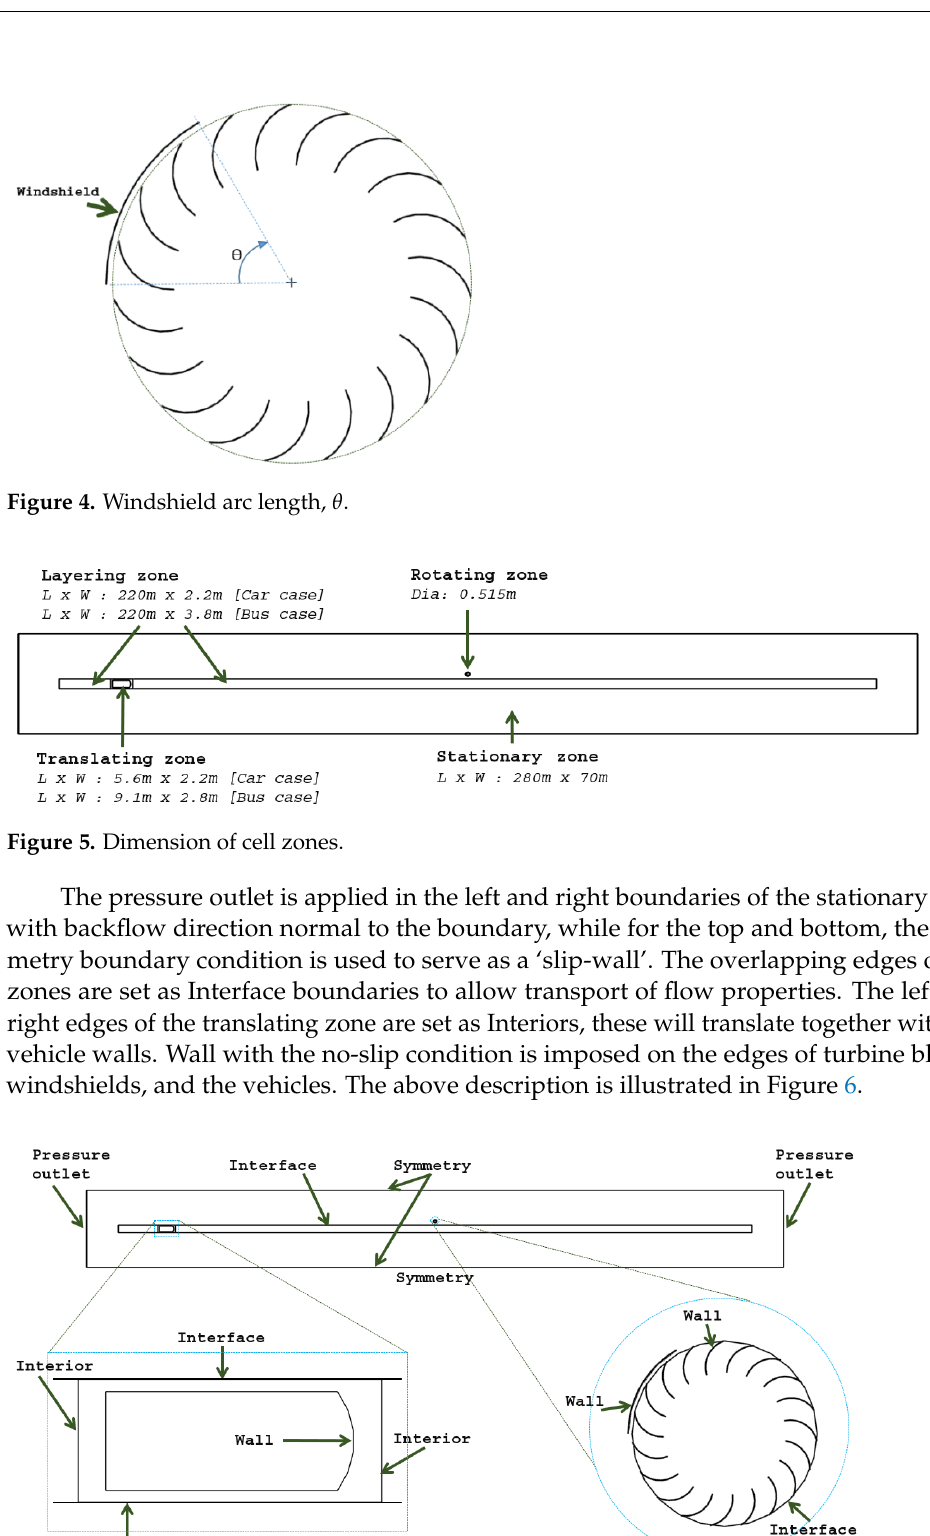
Figure 6. Boundary conditions and mesh interface.